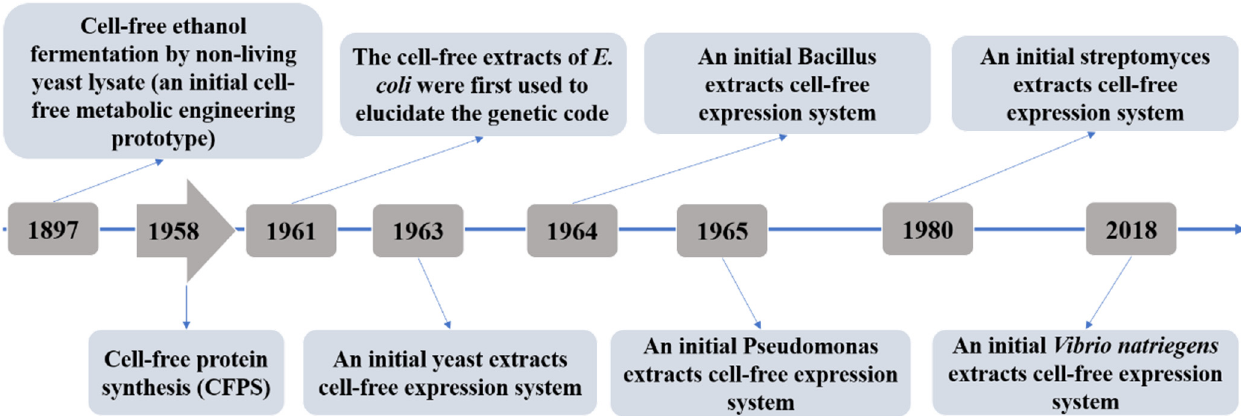
Figure 2. Study of synthetic biology using cell-free crude